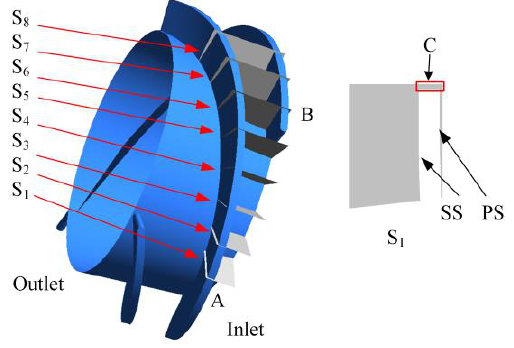
Figure 8. Schematic of the sections.